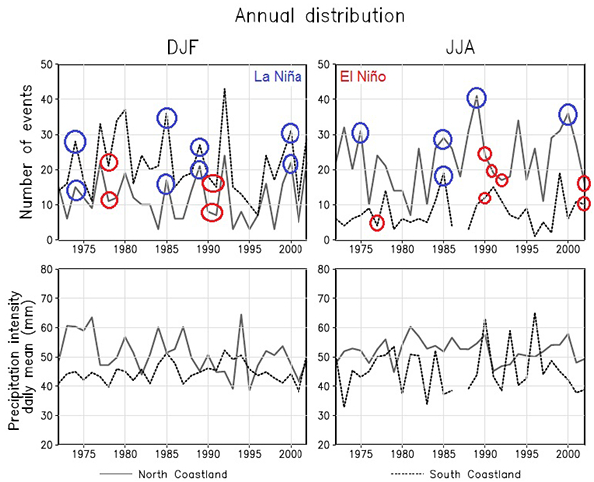
Fig. 2. Annual distribution of the number of EPI and precipitation